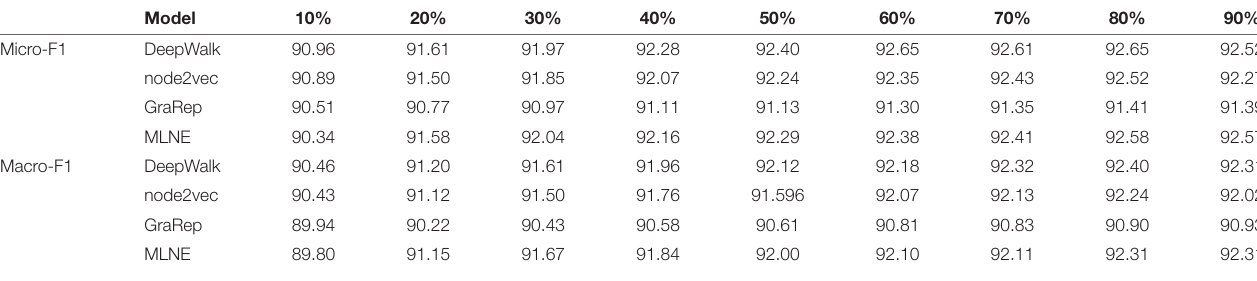
TABLE 3 | Node classification results on